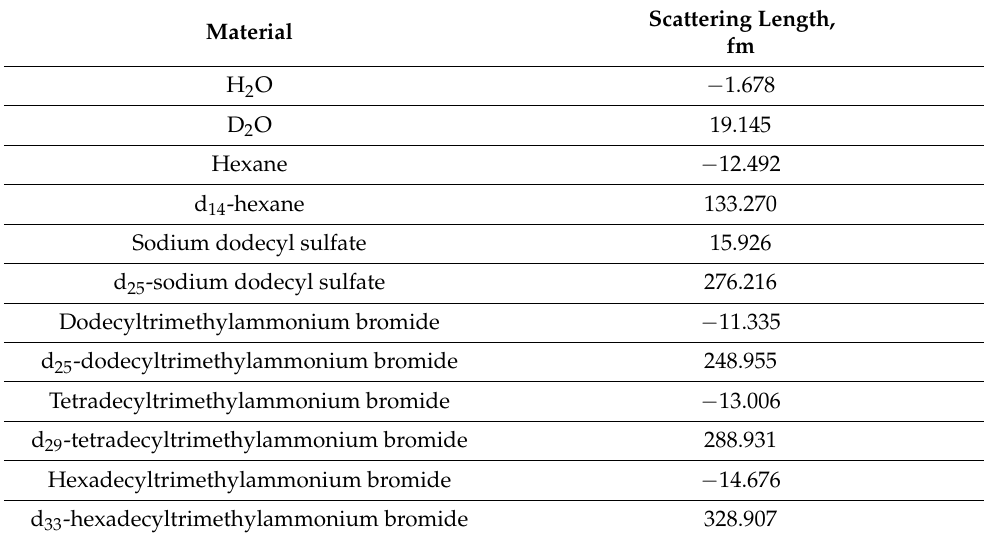
Table 1. Scattering lengths of interfacial materials used in this